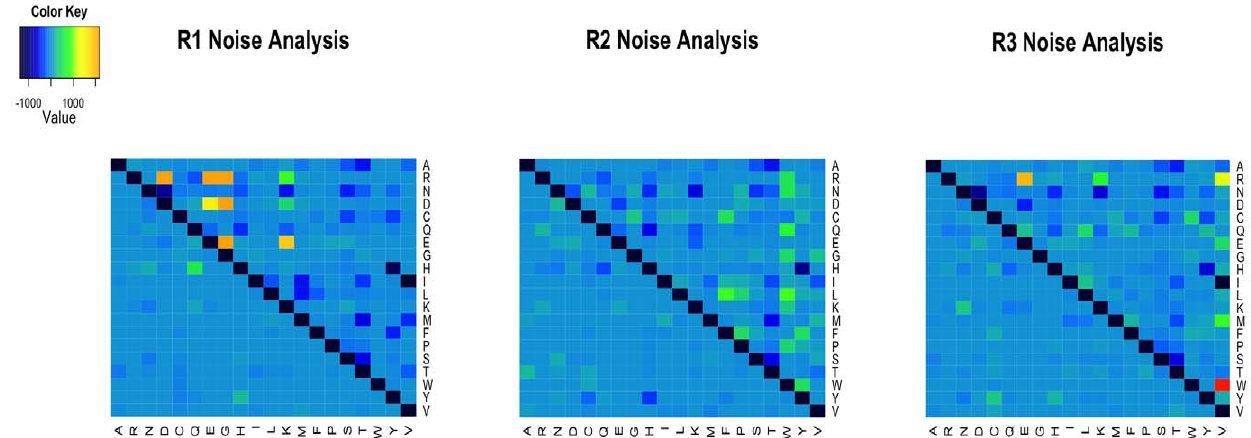
Figure 5. Heatmaps showing the difference between the group-specific rate matrices ( R 1 , R 2 , R 3 ) and the rate matrix estimated from the complete dataset ( R 0 ). The upper right triangle gives the difference between a partition derived from K-means clustering of the mammal data and mtMamR0. The lower left triangle gives the difference between a random grouping of mammalian sites and mtMamR0. Random groupings were constrained to the same size as the groups obtained by using K-means clustering. Panel (A) is for group 1 (1750 sites). Panel (B) is for group 2 (1025 sites). Panel (C) is for group 3 (805 sites).